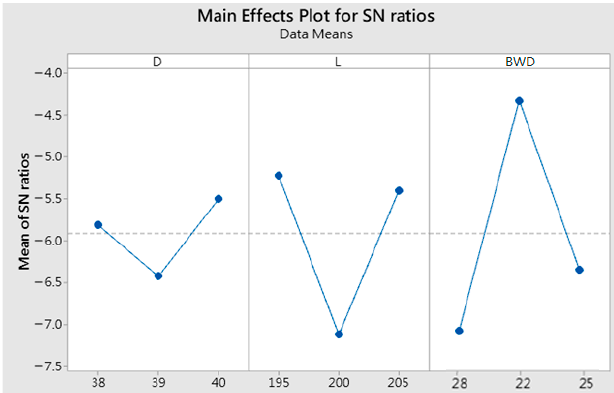
Figure 8. Response diagram for the grey relational grades.